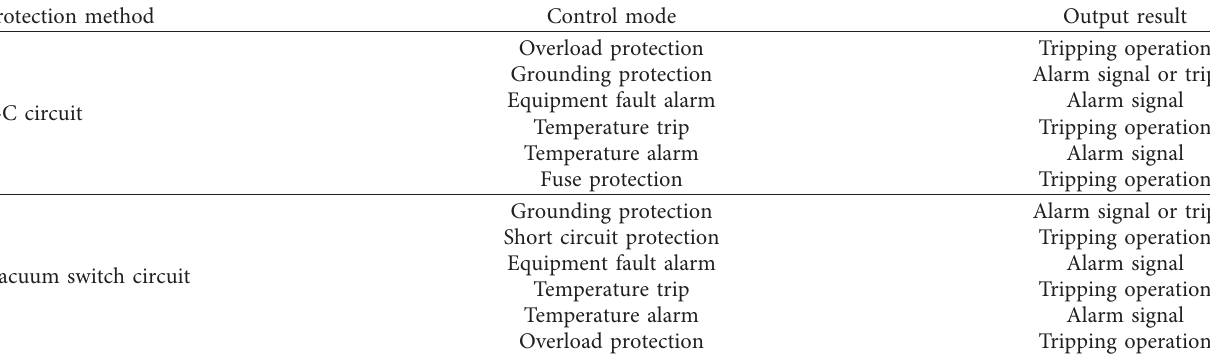
Table 1: Transformer protection control mode.